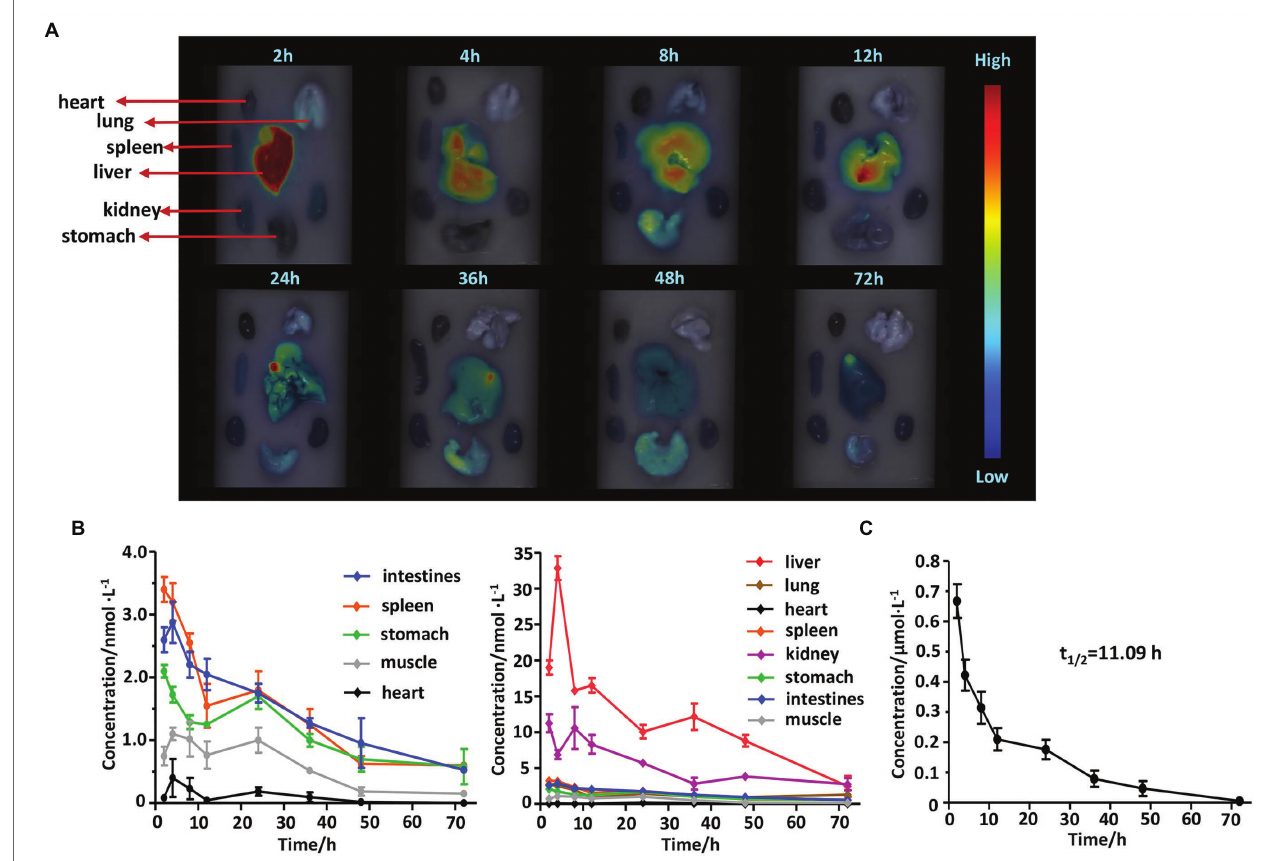
FIGURE 8 | Biodistribution and clearance of PcG 3 K 5 (RW) 3 in mice. (A) Ex vivo fluorescence images of resected organs and tissues from the mice at different time points after injection (2–24 h post-injection). (B) Concentration of PcG 3 K 5 (RW) 3 in various organs and tissues at different time points after injection in 72 h after intravenous injection. (C) The concentration of PcG 3 K 5 (RW) 3 in mouse blood at different time points after intravenous injection. Error bars indicated SD for three